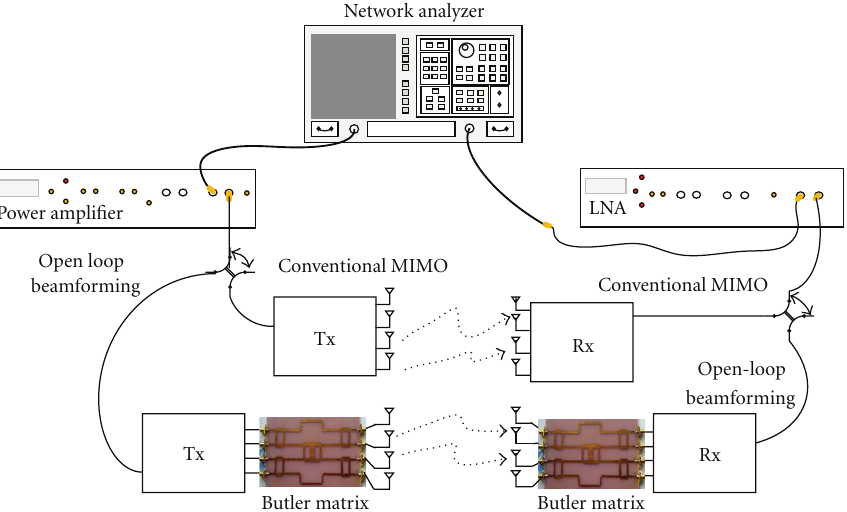
Figure 6: Block diagram of measurement setup.